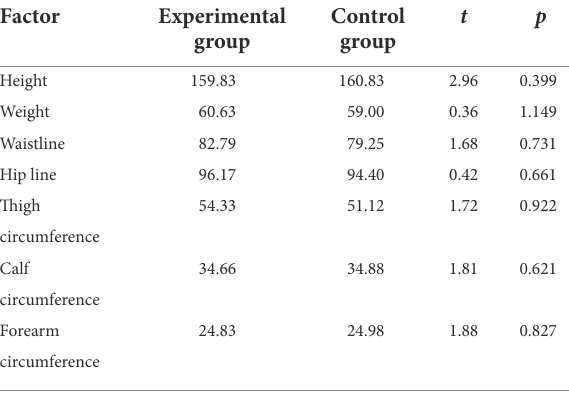
TABLE 8 The body esteem scale of the experimental group and the control group before the experiment. Factor Experimental group